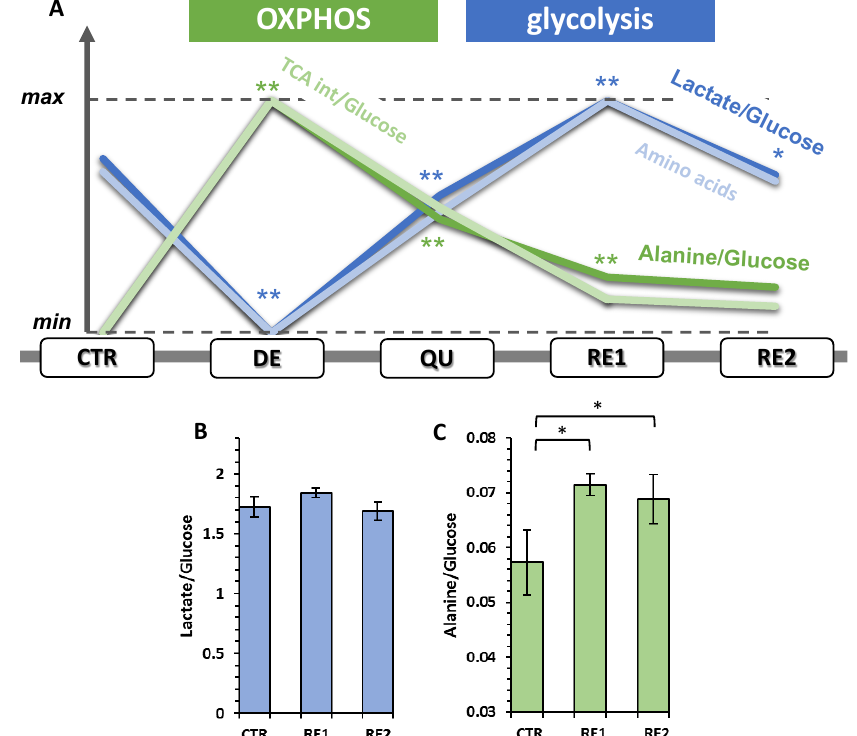
Figure 8. ( A ) Variation of the glycolysis and OXPHOS relative weight during CRAC. Significant lysine, threonine, methionine, phenylalanine, and tyrosine exchange rates. ( B ) Histogram of the Lactate/Glucose ratio for CTR, RE1, and RE2. (C) Histogram of the Alanine/Glucose ratio for CTR, RE1, and RE2. Significant differences are indicated with ** for p < 0.01 or * for 0.01 < p <